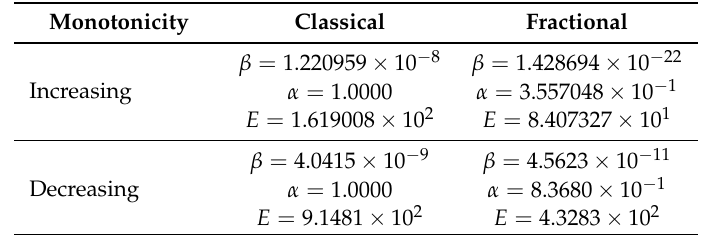
Table 4. Best fitted values of the parameters and corresponding residual errors.